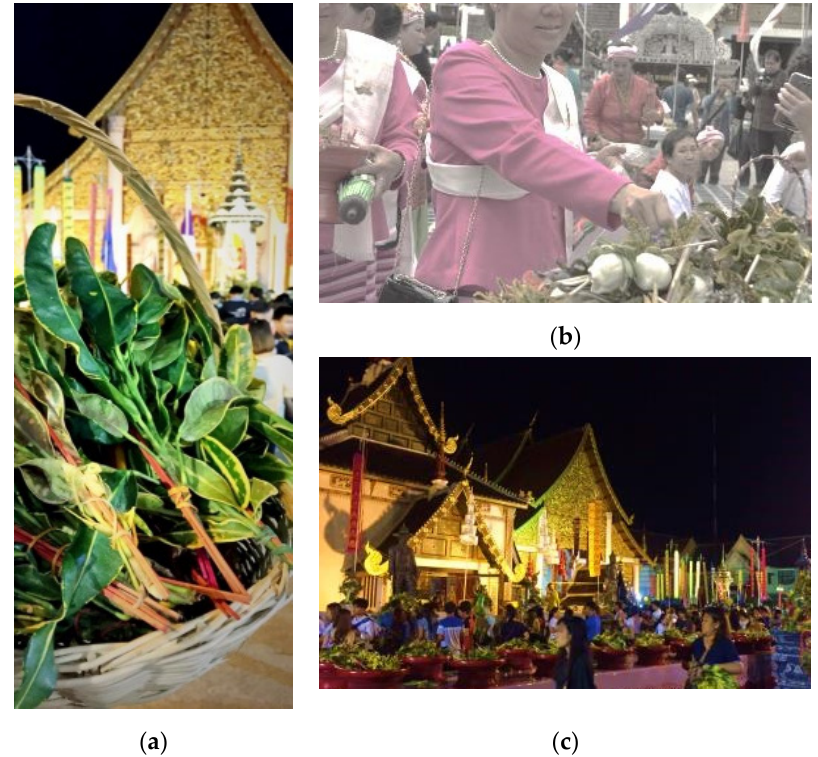
Figure 9. ( a ) Holy leaf and flower with one candle and three incenses for the rite (Author). ( b ) Lo- cal People wears Lanna traditional dress for the religion event (Author); ( c ) Inthakin Festival (Pray to City Pillar) (Author).